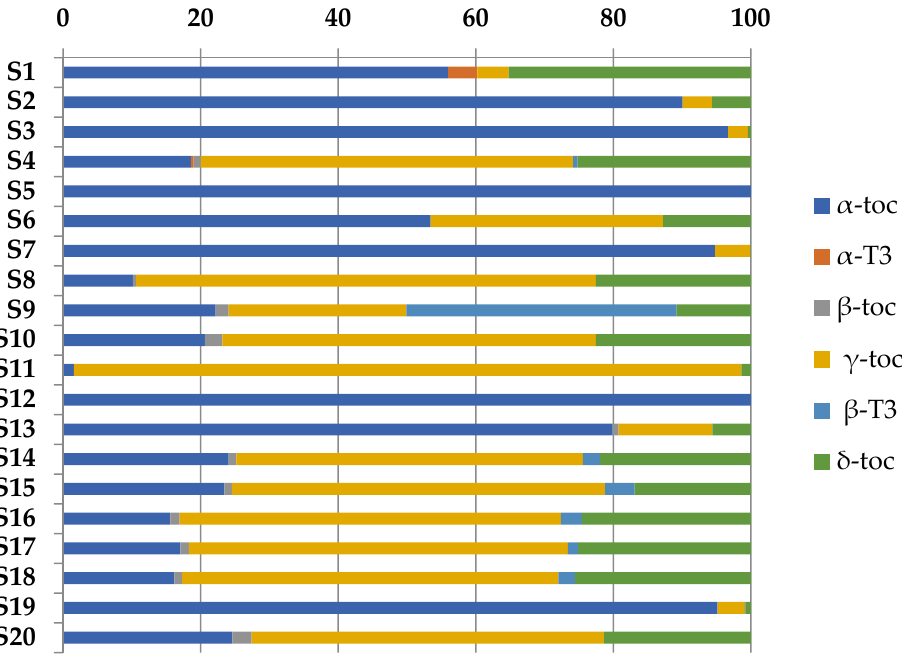
Figure 5. Tocol composition (%) of supplements ( n = 3).